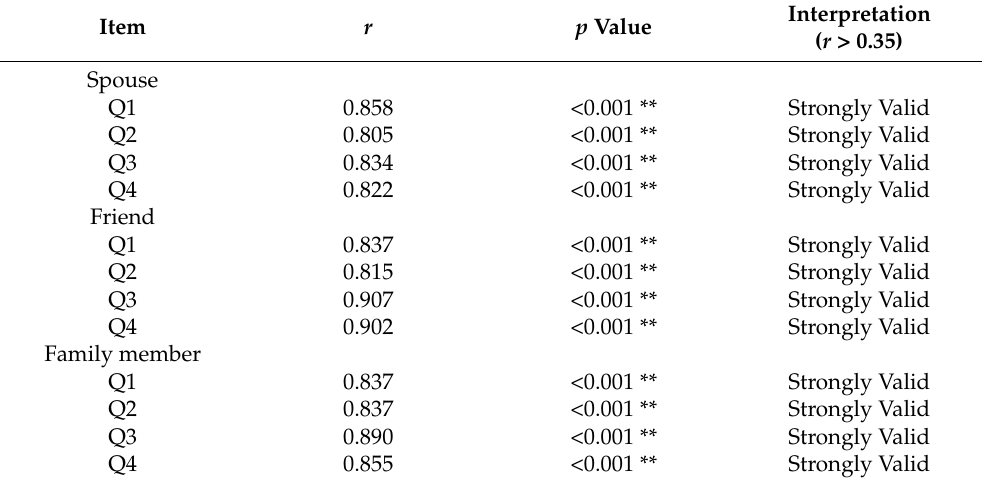
Table 2. NRQ-INA validity test results for each item of the